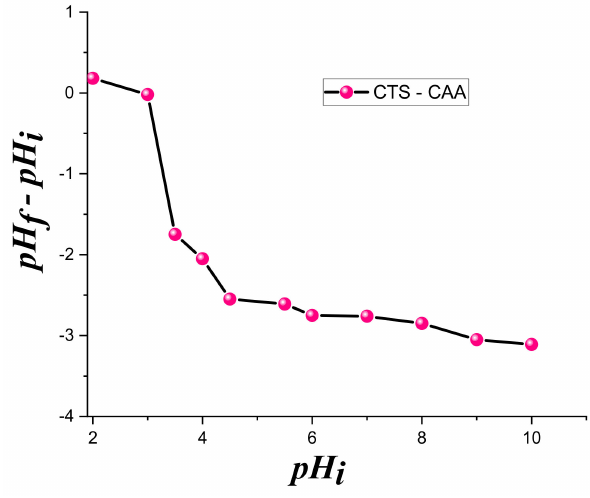
Figure 3. The plot of estimating the pH pzc for CTS-CAA in a 0.1 M NaCl solution based on titration method.